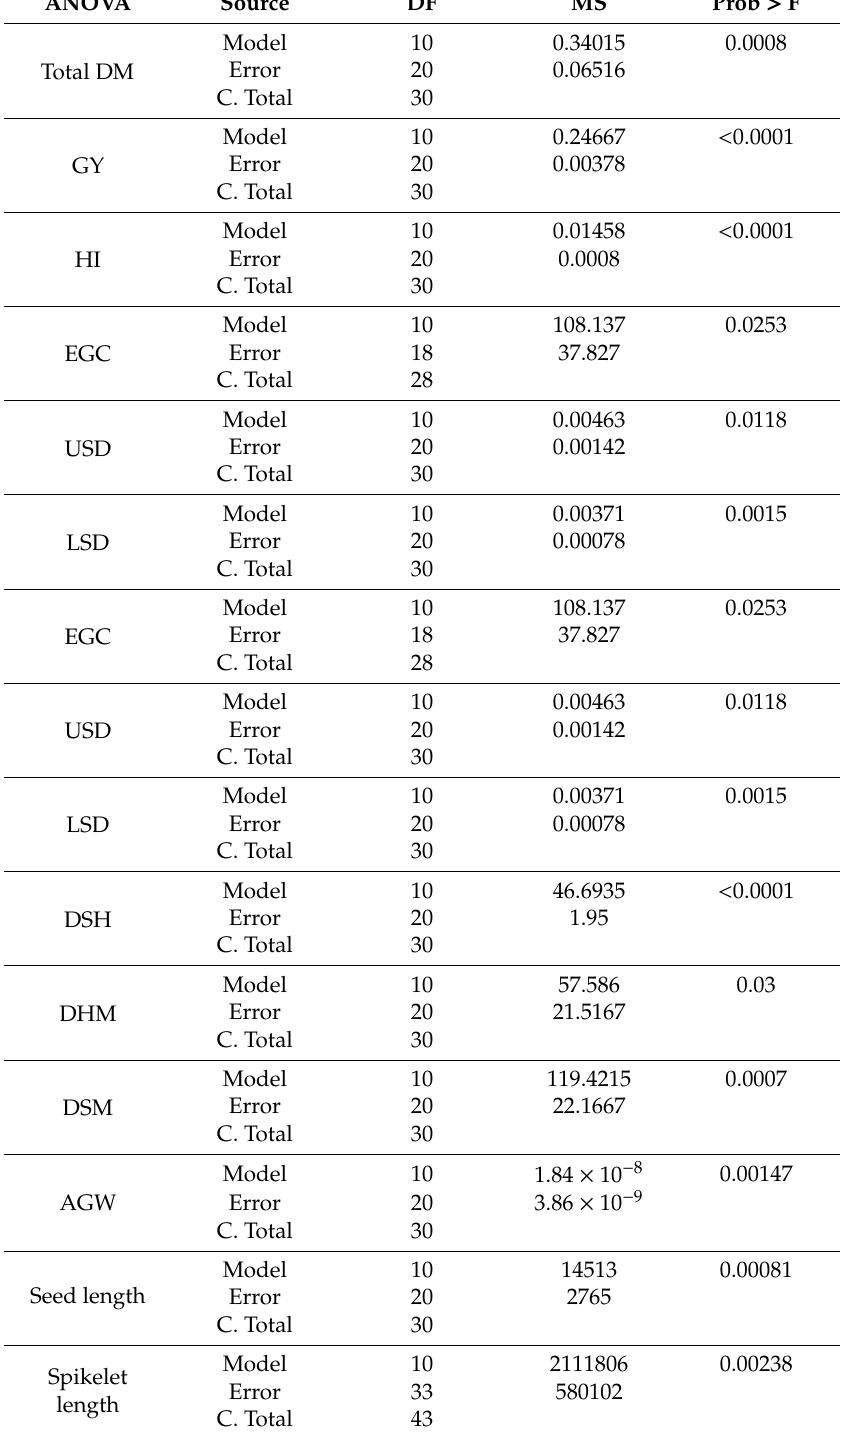
Table 2. Analyses of variance of the di ff erent studied traits for the studied populations as well as the commercial cultivar ’white” under field